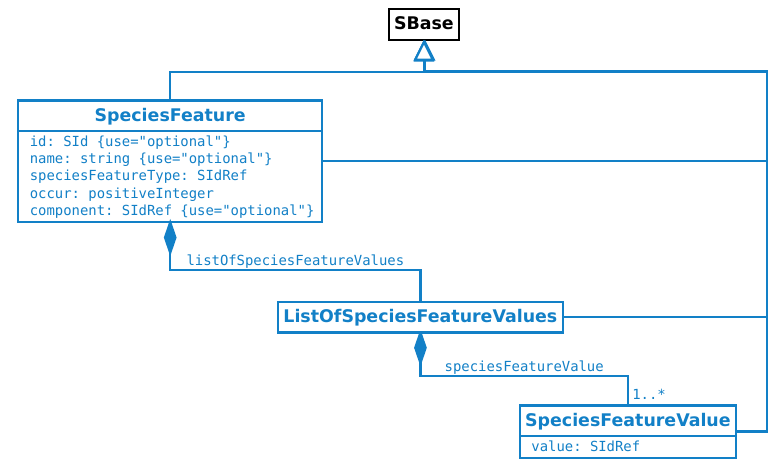
Figure 12: The definitions of the SpeciesFeature class and the SpeciesFeatureValue